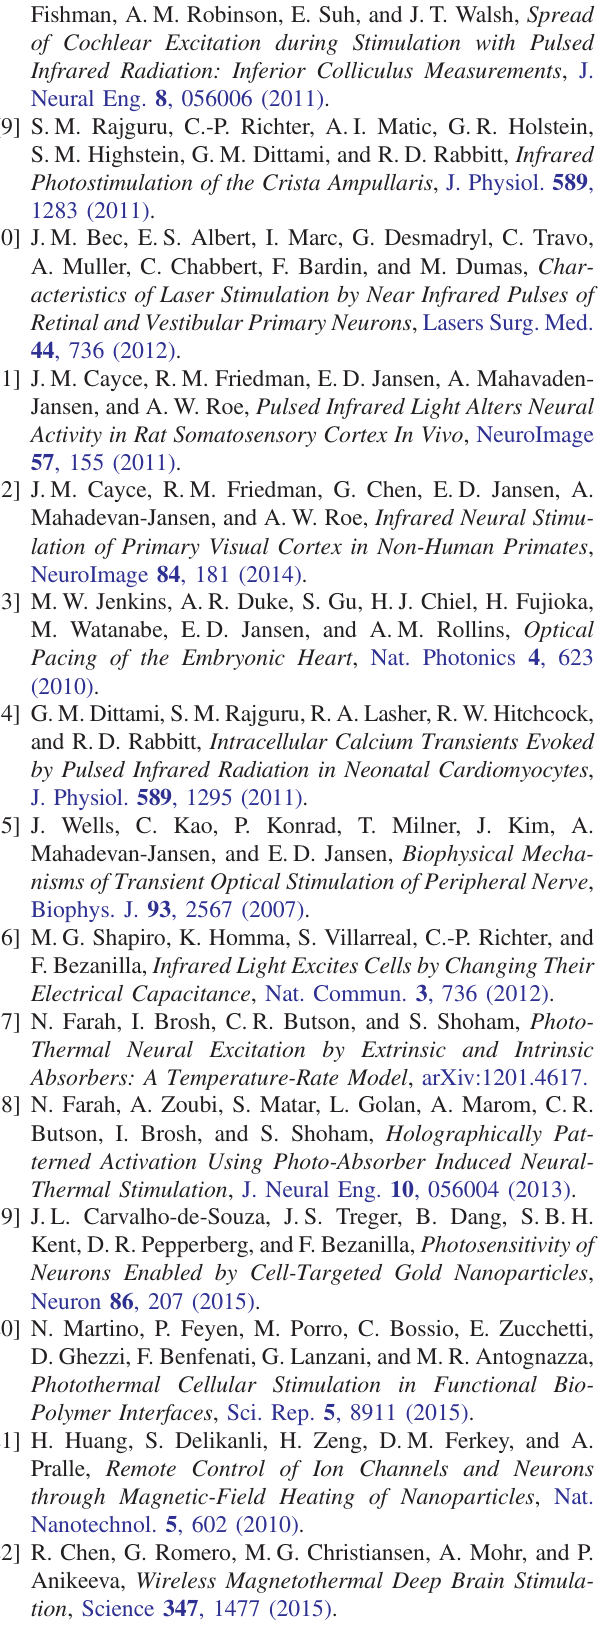
[Figs. 3(c) and 4(f) of their study, obtained by linear regression] and maximal capacitance change percentage [Fig. 3(e) of their study] for energy − 7 . 3 mJ and duration − 10 ms; the slopes represent temperature-induced maxi- mal capacitance change [seen from integration of Eq.